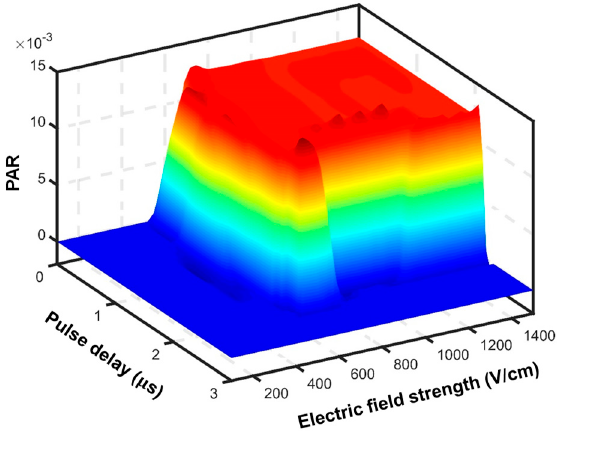
( d ) Figure 6. The joint effect of the pulse delay and the electric field strength on ( a ) PAR and ( b ) the time required to reach plateau when the pulse width is 1 μs ; The joint effect of the pulse delay and the electric field strength on ( c ) PAR and ( d ) the time required to reach plateau when the pulse width is 2 μs . 4. Discussion In the present study, the dynamics of pore evolution caused by symmetric bipolar H- FIRE protocols were investigated using a proposed SCE model, which integrates electric field theory and pore mechanics to provide a principle-based modeling approach. The SCE model demonstrated the process of pore evolution within a pulse burst, showing most pores occur in the transition and polar regions during the administration of the first pulse in a small size (i.e., <5 nm), and the pores located in the transition region are found to expand to tens to hundreds of nm in diameter with the delivery of pulses (see Figure 4a). In the early phase of a pulse burst (e.g., the first 8 microseconds), the polar region and transition region contributed to PAR at the same magnitude, but in the later phase of the pulse burst (e.g., after 100 microseconds), large pores started to evolve in the transition regions and composed the majority of PAR (more than 95%) due to the cumulative effect of ongoing exposure to H-FIRE protocols. The cumulative effect was found to be critical in the electroporation dynamics, and this should guide the design of protocols to have a high probability of cell death. In this study, four pulse-setting parameters (pulse width, pulse delay, pulse burst duration, and